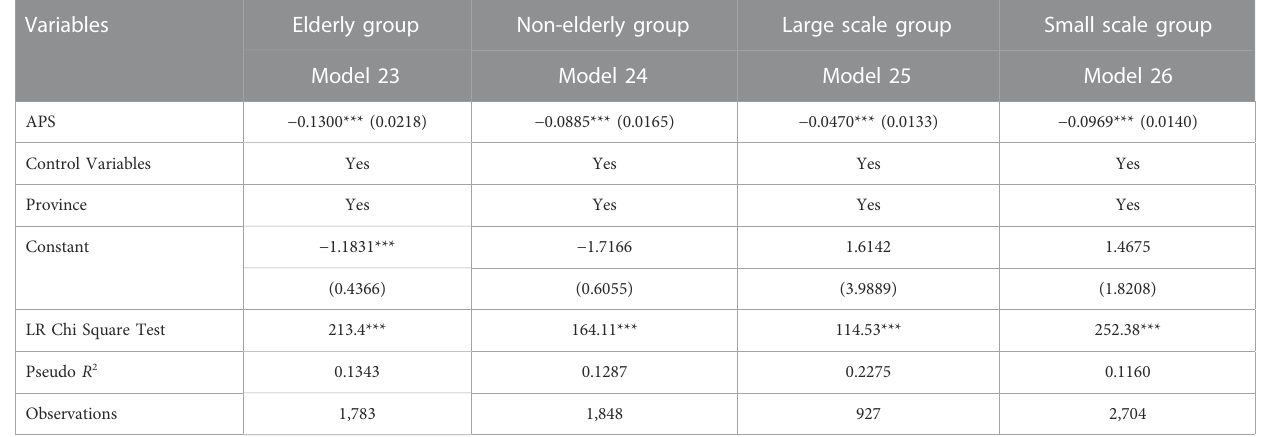
TABLE 5 Estimated results of individual